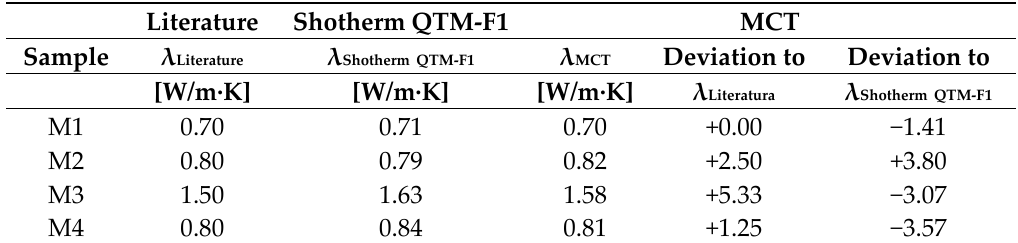
Table 3. Thermal conductivity measurements and